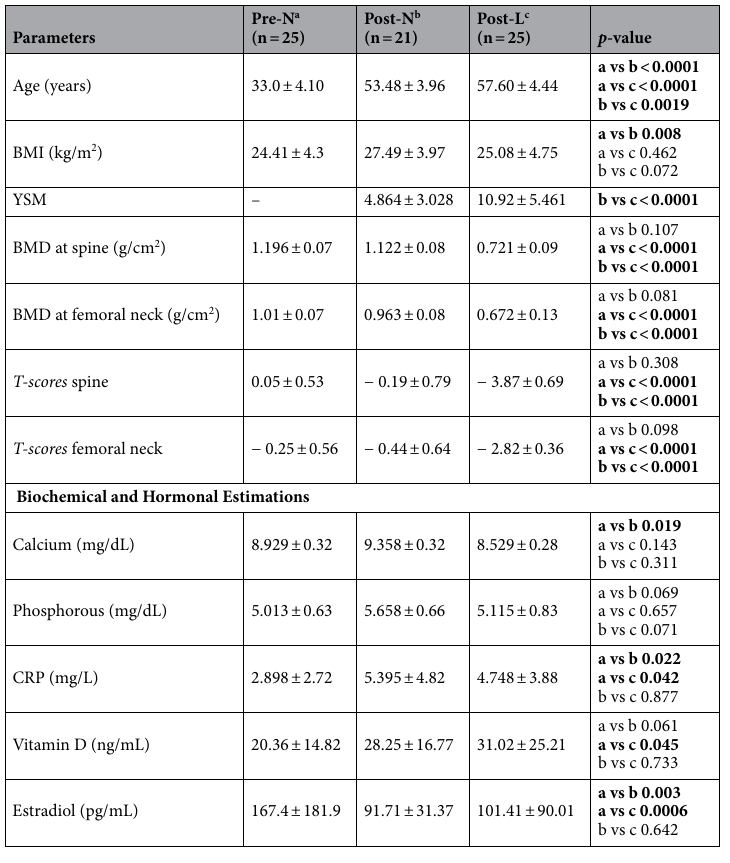
Table 1. Baseline demographic and clinical characteristics of the study cohort (n = 71). Values are represented as Mean ± SD; p value < 0.05 is considered significant and marked in bold. Abbreviations: Pre-N premenopausal women with normal BMD, Post-N postmenopausal women with normal BMD, Post-L postmenopausal women with low BMD, BMI Body Mass Index, YSM Years since Menopause BMD Bone Mineral Density, CRP C-Reactive